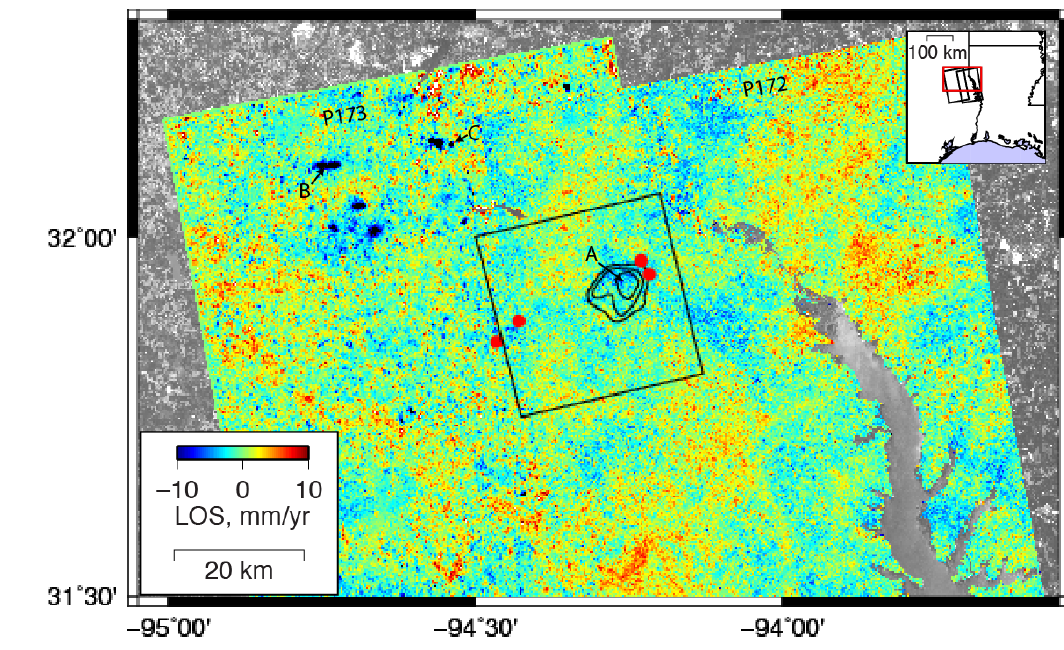
Figure 16. Secular rate from ALOS-1 time series (color) in eastern TX, where Shirzaei et al. [68] analyzed a subset of the area (black box) covered by two frames and reported ground uplift (black contours) associated with wastewater injection at several sites (red dots). Blue indicates shortening of the satellite LOS (e.g., uplift) in mm/yr, and we did not find a clear uplift signal above background in the area reported by Shirzaei et al. [68]. Note much larger signals to the northwest of the earlier study—these have magnitudes of − 2 to − 5 cm/yr. Letters and arrows indicate the location of the time series in Figure